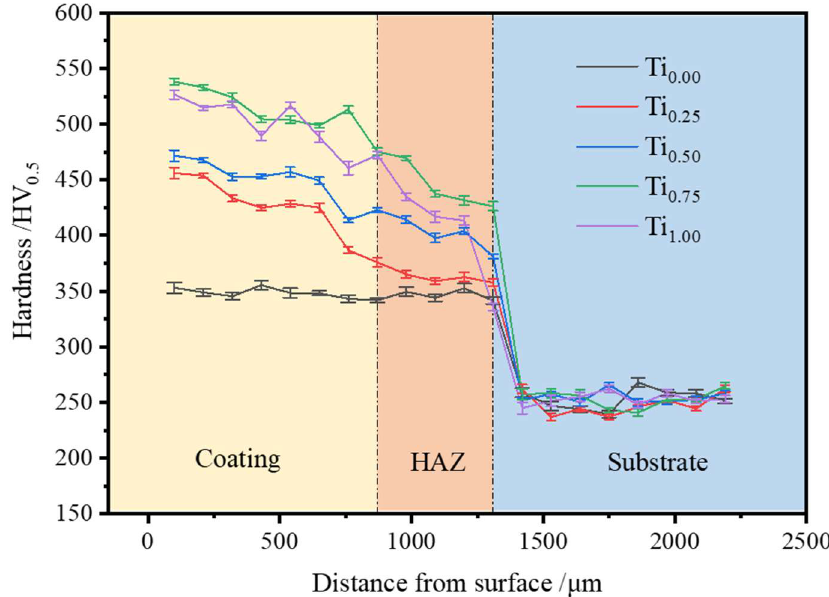
Figure 6. Microhardness distribution curves of CoCrFeMnNiTi x alloy coatings with different Ti con- tents.